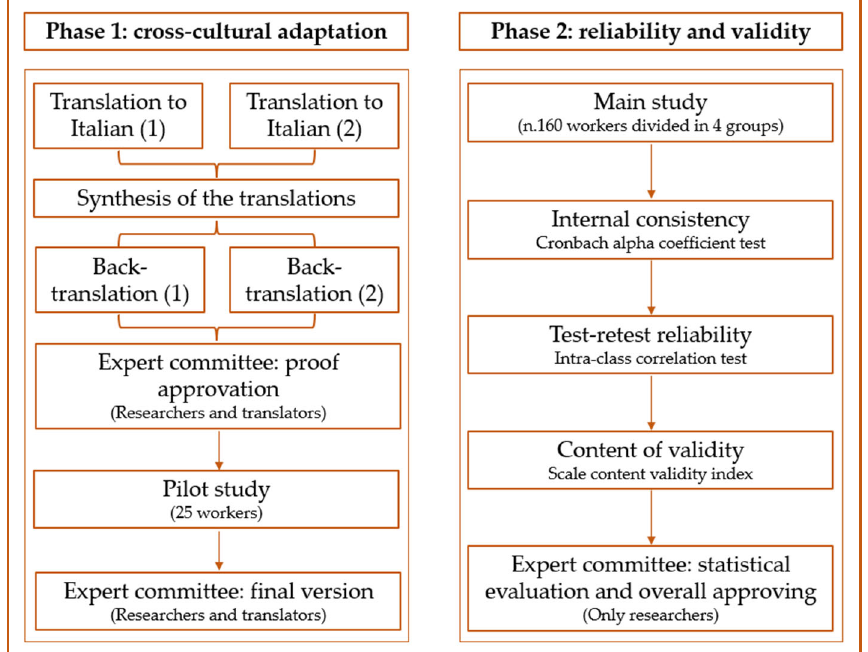
Figure 1. Cross ‐ cultural adaptation, reliability, and validity of the Italian version of adult Vaccine Hesitancy Scale (aVHS) for the working ‐ age population.